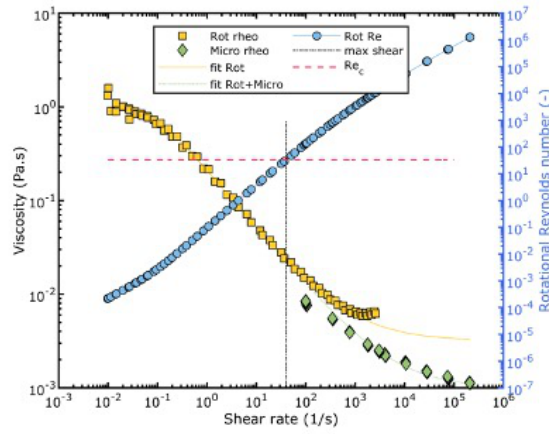
Figure 2: Determination of the onset of inertial effects for xanthan gum solution 0.08% w/w using the cone-plate geometry 60-2 (60mm diameter and 2 ∘ angle). In legend: viscosity measurements from rotational rheometer (Rot rheo), viscosity measurements obtained with microfluidic rheometer (Micro rheo), model fit for data from rotational rheometer (fit Rot), model fit for data from mi- crofluidic rheometer (fit Rot+Micro), calculated rotational Reynolds numbers (Rot Re), shear rate where instabilities begin to appear (max shear) and calculated critical Reynolds number (Re c